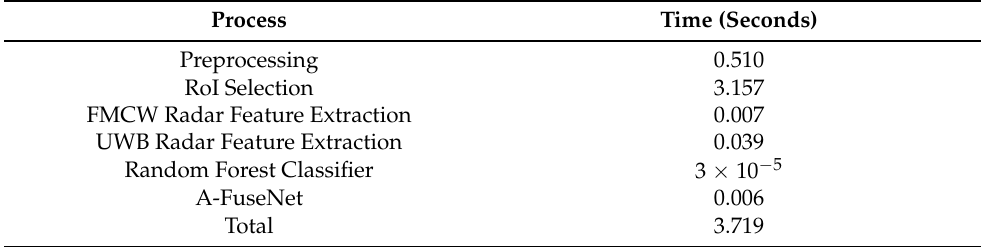
Table 10. Time processing for activity and vital sign